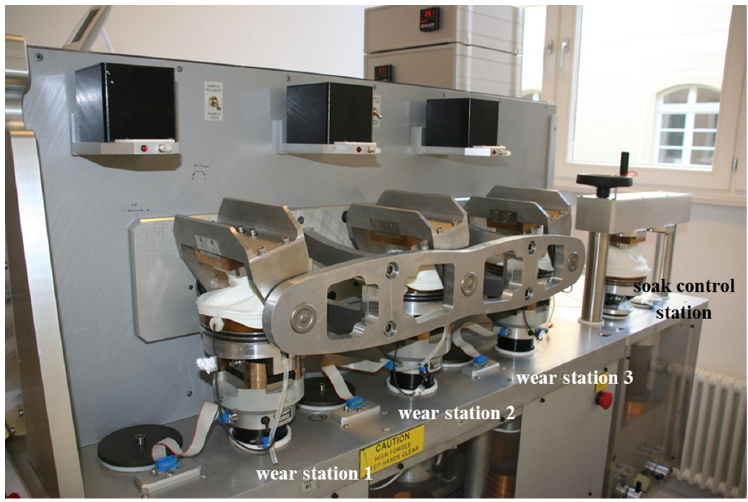
Figure 2. Knee wear simulator with three wear stations and one soak control station.